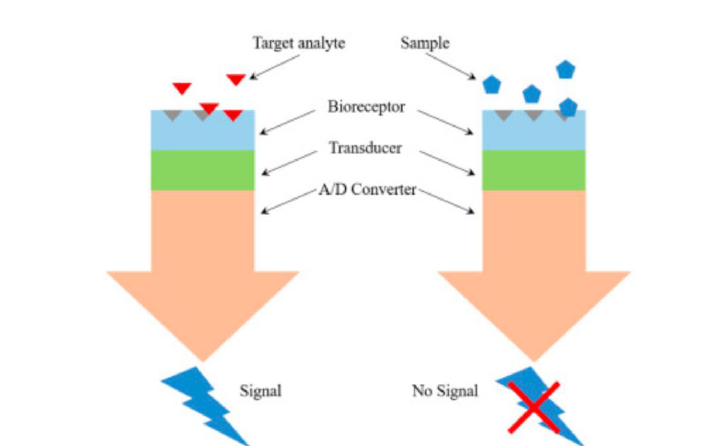
Figure 1: Visual representation of functionality of biosensors and how they produce a signal